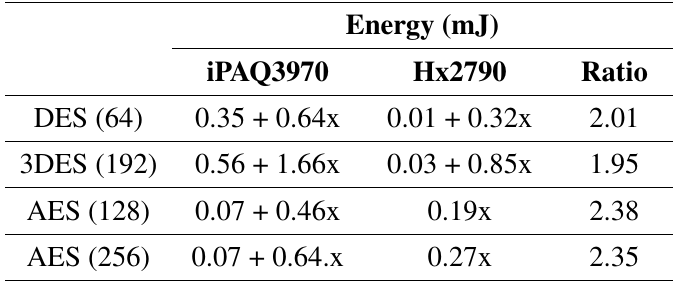
Table 4. Energy costs of symmetric algorithms in a PDA